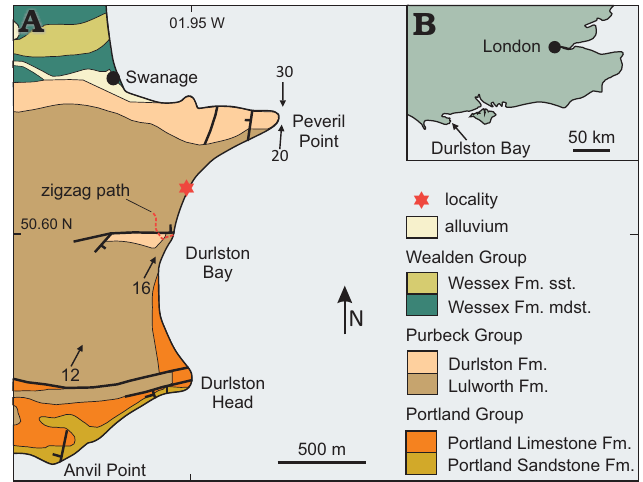
Fig. 1. A . Outline geological map of Durlston Bay and the southern part of Swanage Bay, east Dorset, United Kingdom showing the locality. Arrows indicate dip. B . Location map. Abbreviations: Fm., Formation; mdst., mud- stone; sst.,